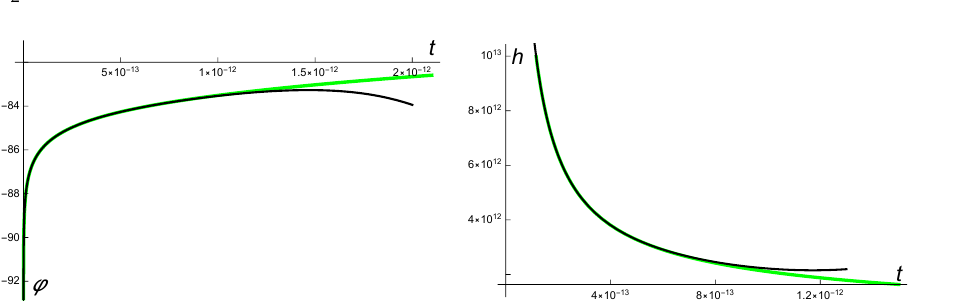
Figure A2. The green lines show the numerical solutions ϕ ( t ) of (9) ( left ) and h ( t ) (10) ( right ) with initial conditions t 0 = 10 − 13 , ϕ 0 = ϕ (cid:114) ( − ) ( t ) 2 − v ( ϕ ) . The black lines show the 6-order approximations ϕ ( − ) h 0 , b 0 ,0 0 approx ,6 ( − ) ( t , b ) ( right ). We also take λ = ( left ) and h 0 ,0 approx ,6